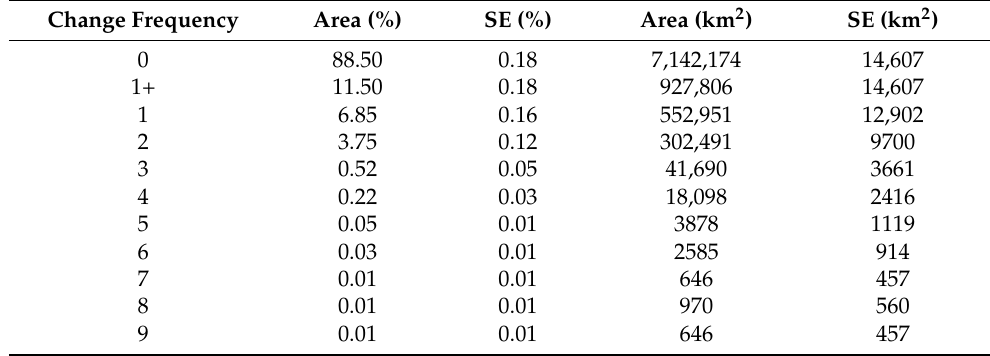
Table 2. Estimated area footprint of change and area of individual change frequencies based on the reference dataset (frequency of 0 represents the no-change footprint and frequency of 1+ represents the change